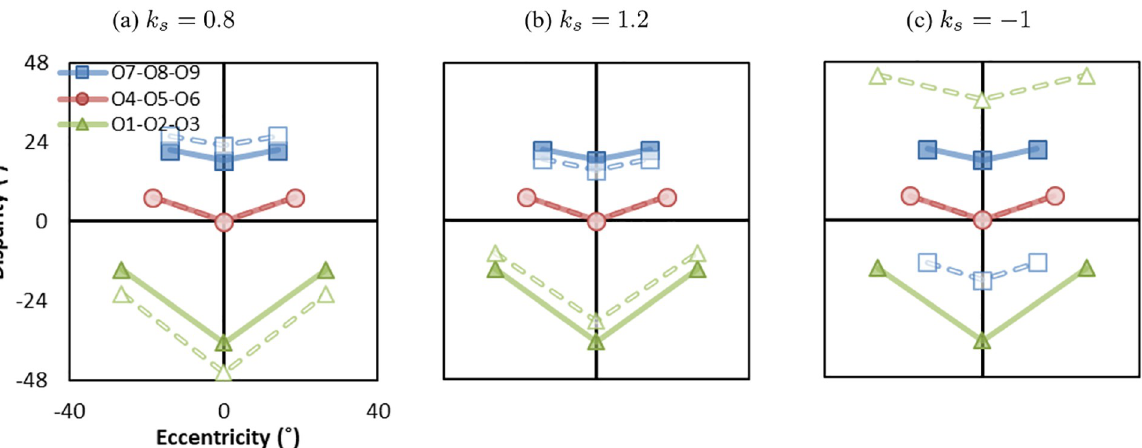
= 0.8), (b) Eye separation is larger than s = − 1), called psudoscope. Solid lines represent the s